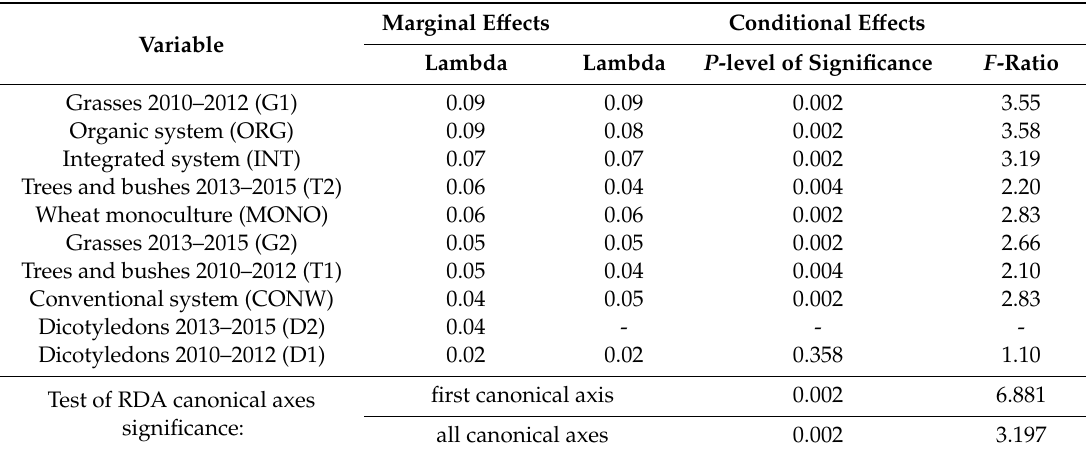
Table 4. The results of forward selection of variables and the Monte Carlo permutation test using CANOCO. Marginal E ff ects Conditional E ff Variable